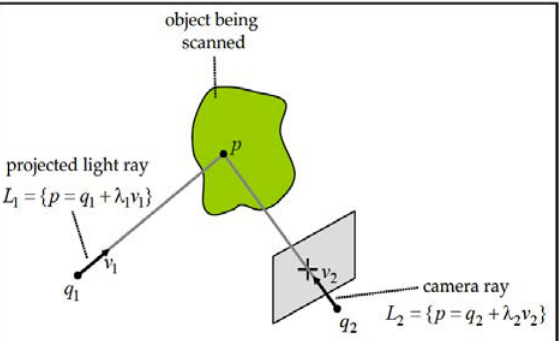
Figure 5: Stereo ray-ray triangulation